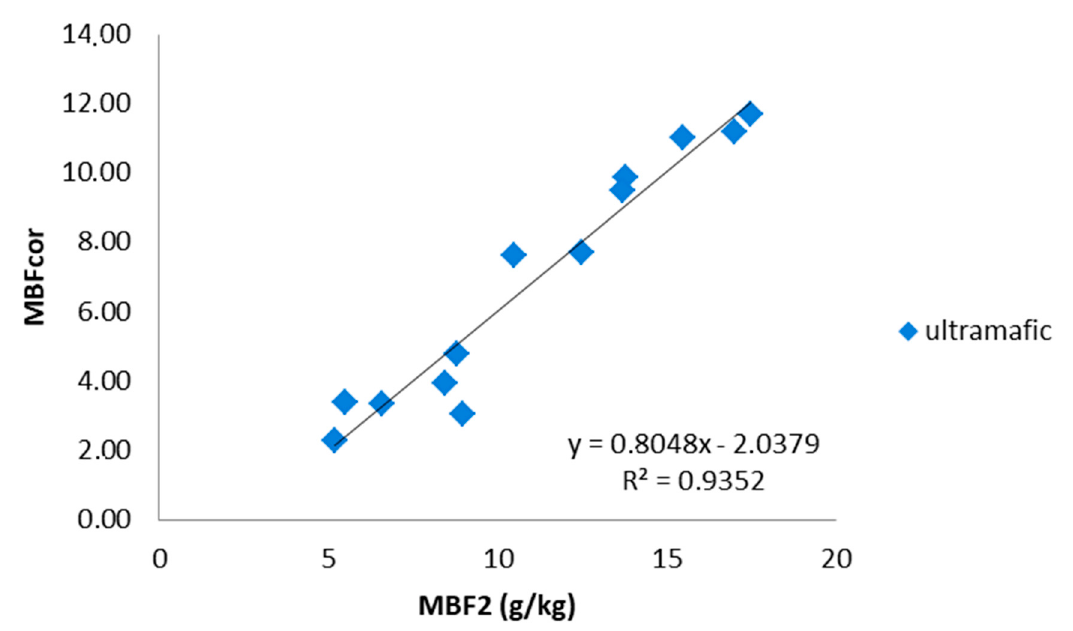
Figure 11. The modified methylene blue test (MB F 2) plotted against the correction index of the methylene blue test (MB Fcor ) of the ultramafic rock samples.